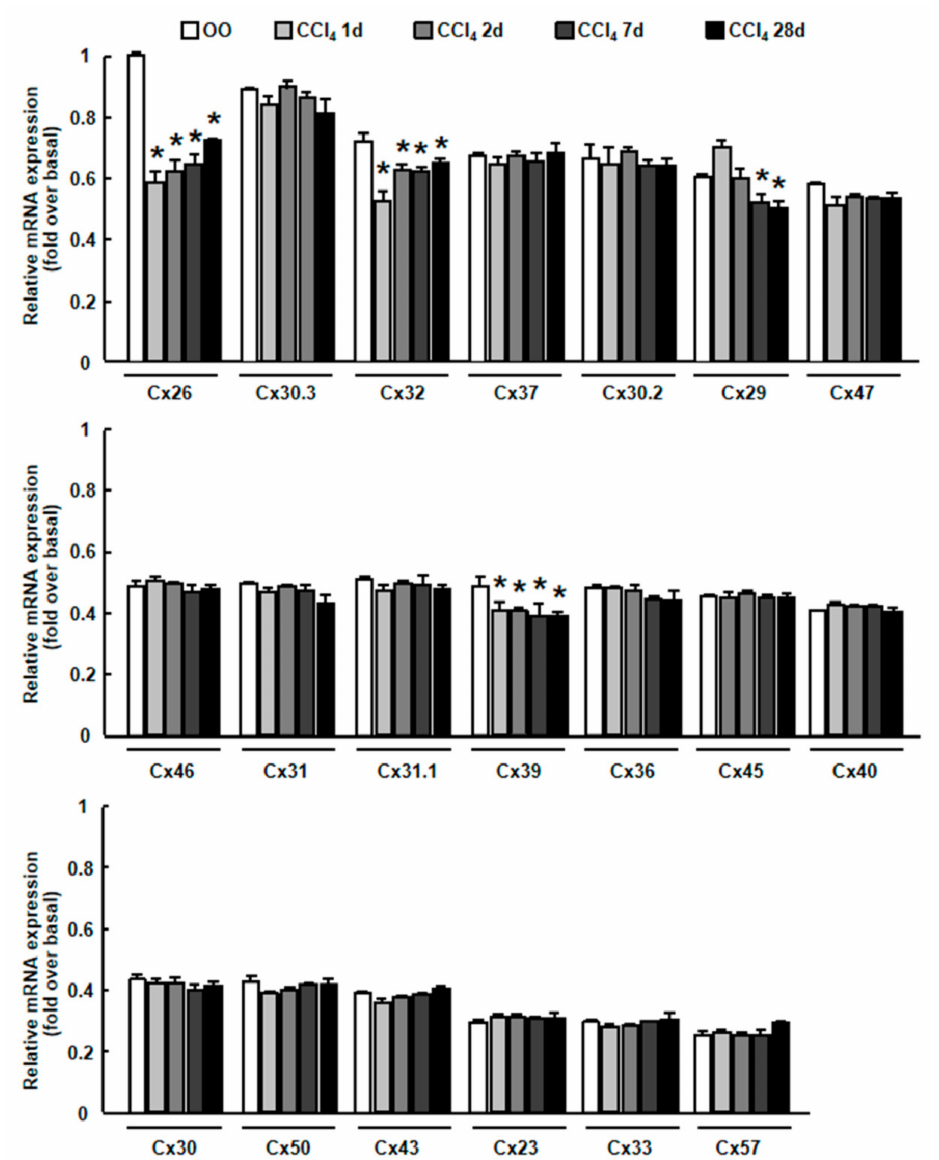
Figure 1. The expression pattern of multiple connexins in carbon tetrachloride (CCl 4 )-injured mouse liver. The mRNA expression of di ff erent connexins was examined by a quantitative real-time reverse transcription polymerase chain reaction (qRT-PCR) in liver injury mice induced by CCl 4 . Data are presented as the mean ± SEM, and were analyzed by Student’s t-test for analysis of variance. * p < 0.05 vs . OO-treated